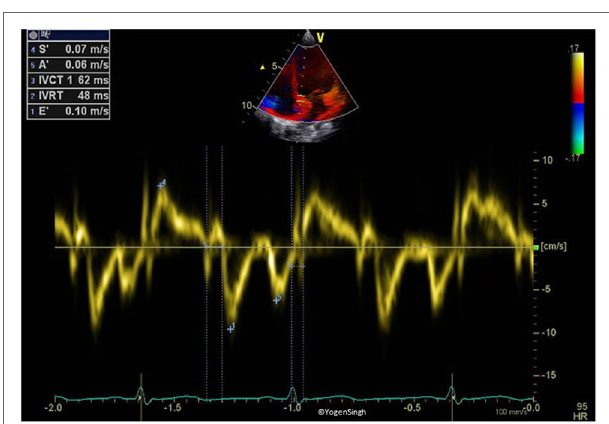
FiGURe 4 | Tissue Doppler imaging on pulse-wave Doppler of interventricular septum (myocardium). Spectral above the baseline (s ′ ) reflects the movement of myocardium toward apex in systole while below the baseline (e ′ and a ′ ) reflects the movement of myocardium away from apex in